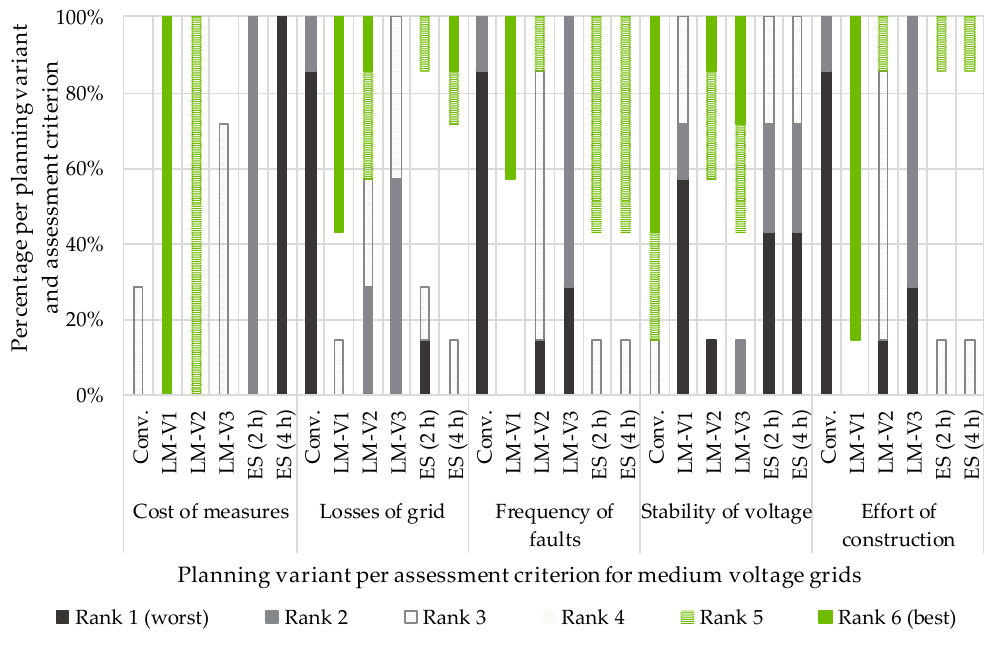
Figure 23. Ranking of the six planning variants for each assessment criterion.